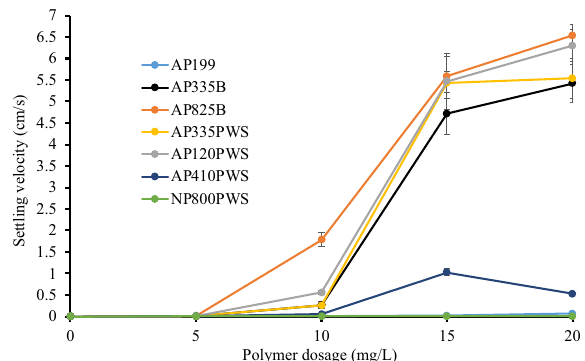
Fig. 3 Relationship between optimum dosage of the best alkaline agent (Ca(OH) 2 + Na 2 CO 3 ) and seawater salinity ( n = 3, means ± standard deviations). Salinity was adjusted (0 – 3.5%) by diluting arti fi cial seawater with distilled water.